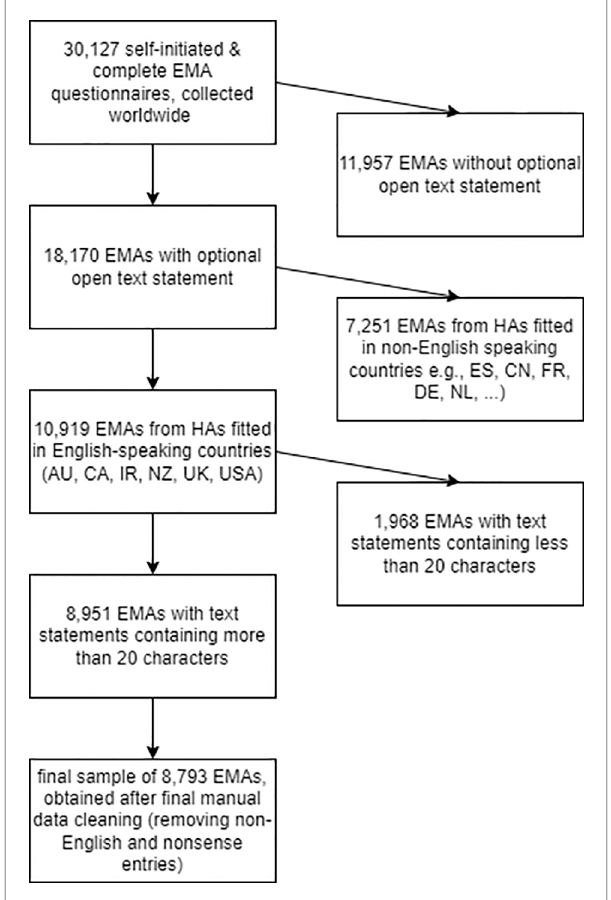
FIGURE 1 Flow chart visualizing how the fi nal sample of 8,793 EMAs considered for further analysis was